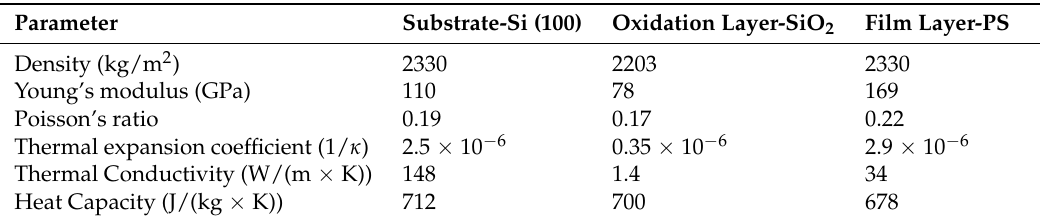
Table 1. Physical properties in layers used in the numerical model.